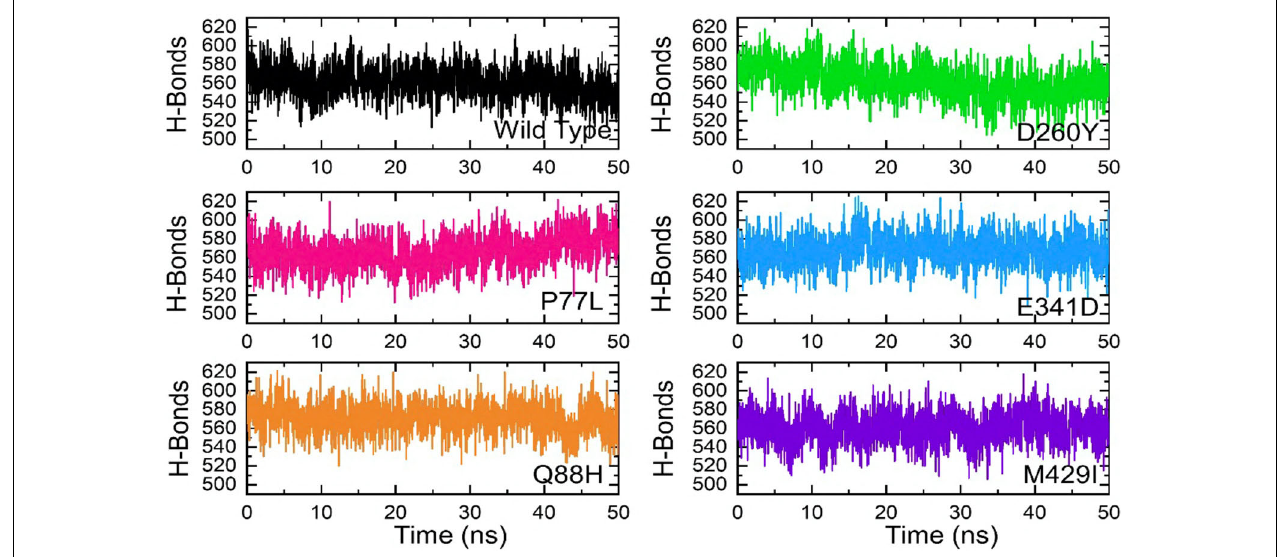
FIGURE 8 | Hydrogen bonding of the WT and mutant complexes calculated as a function of time. The H-bonds for WT are shown in black, while for mutants these are shown in different colors.